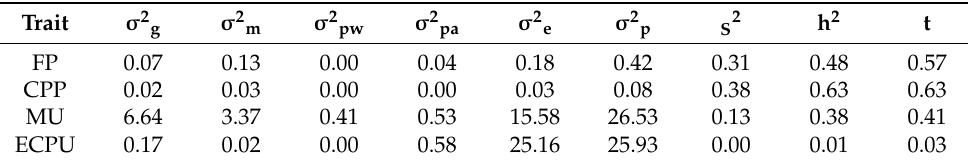
FP = fat percentage, CPP = crude protein percentage, MU = milk urea concentration, ECPU = efficiency of crude protein utilization, σ 2 g = additional polygenic variance, σ 2 m = additive genetic variance explained by the markers, σ 2 pw = within lactation permanent environment variance, σ 2 pa = across lactation permanent environment